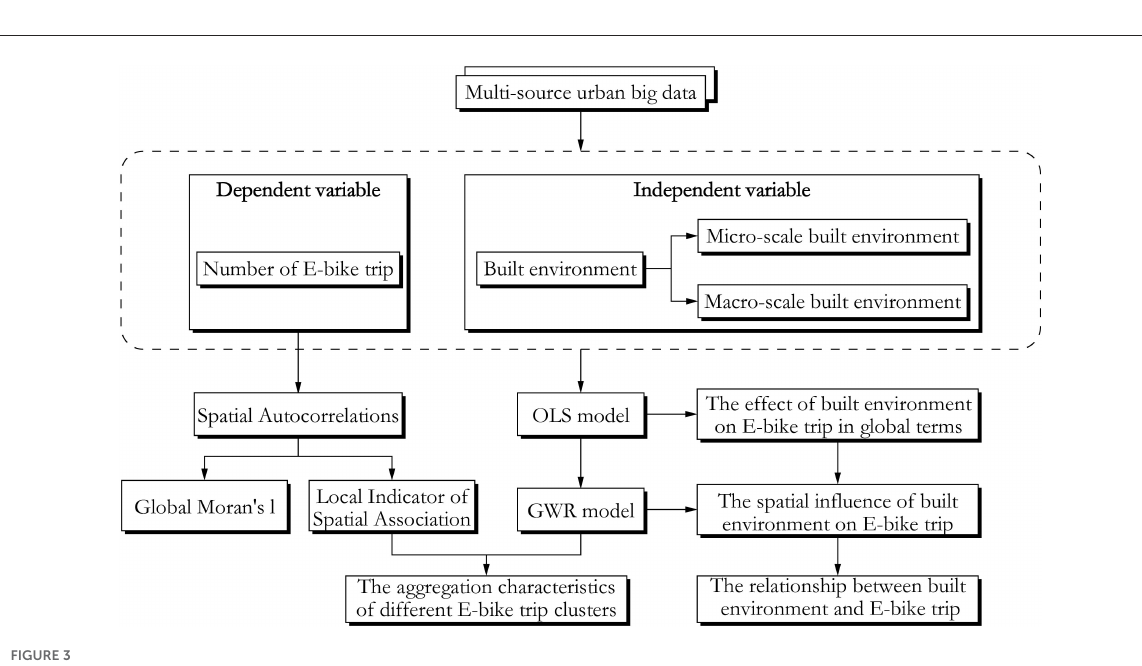
FIGURE3 Technology